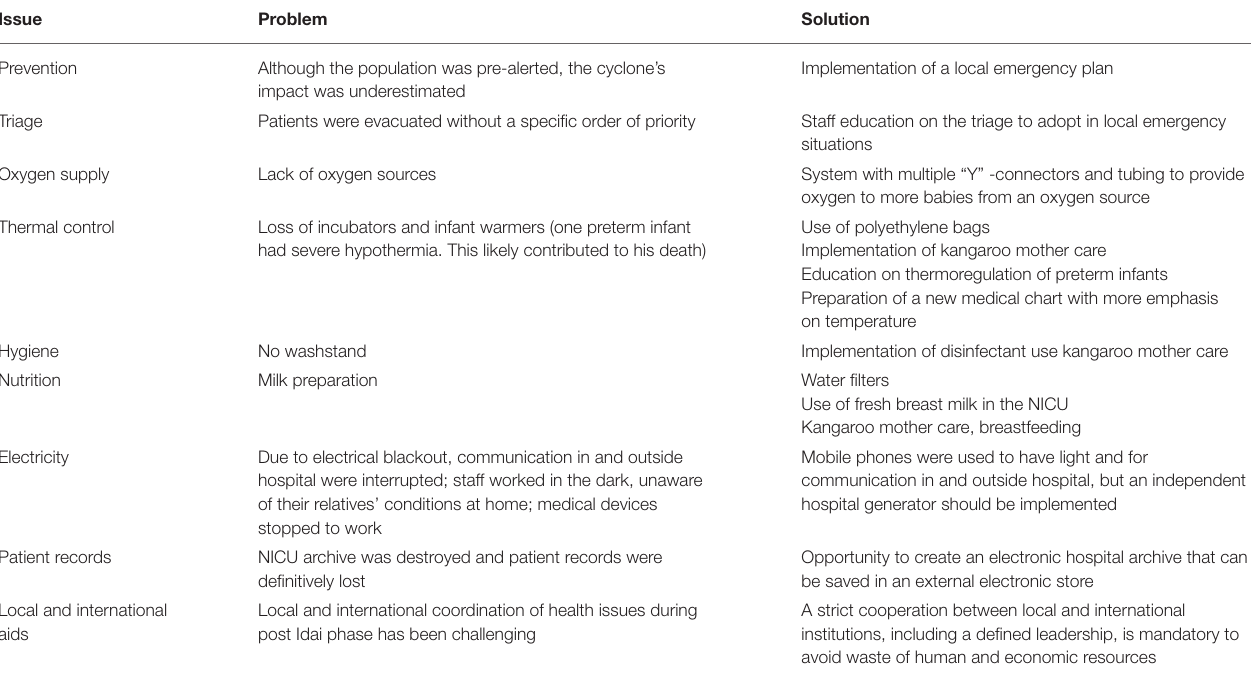
TABLE 1 | Problems and possible